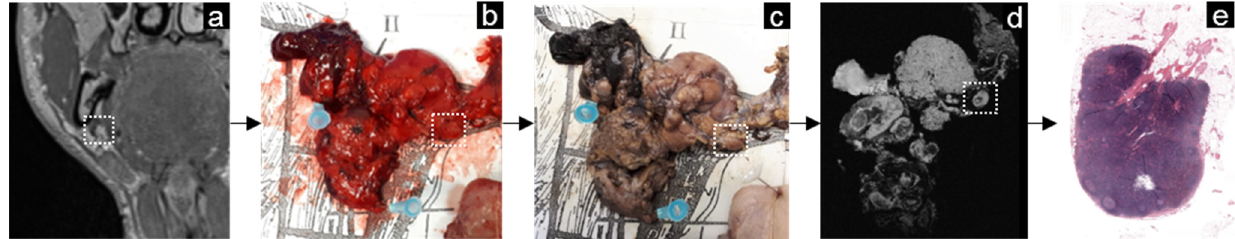
Figure 8. Example of the workflow in head-and-neck cancer. A lymph node was located on the in vivo MR image (( a ) white dashed lined box). After lymphadenectomy, the fresh specimen was pinned to a grid ( b ) and fixated with formalin ( c ). Of the fixated specimen, an ex vivo MRI was performed. The lymph node of interest identified on the in vivo MR image was correlated to the ex vivo MR image ( d ). Since the USPIO surgery interval was 5 days, and USPIO was no longer present in the resection specimen, there were no changes in signal intensity. For this reason, the lymph node maintained a signal on the water-selective ex vivo MR image ( d ). The pathologist was guided by the ex vivo MRI to dissect this node and enclose it separately. Histopathologic examination with hematoxylin and eosin staining revealed a healthy lymph node ( e ).